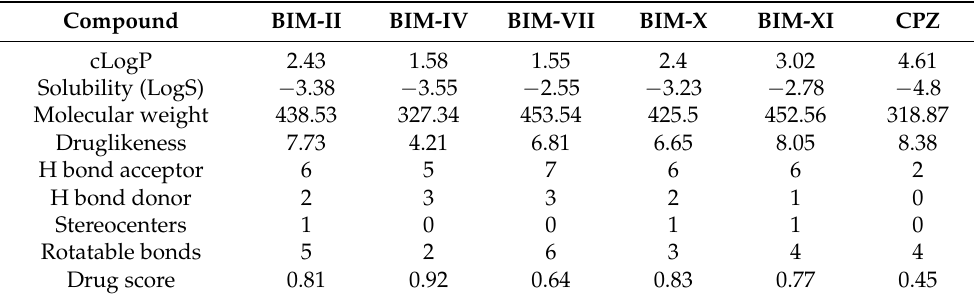
Table 4. Chemoinformatic properties of the BIM and CPZ compounds.